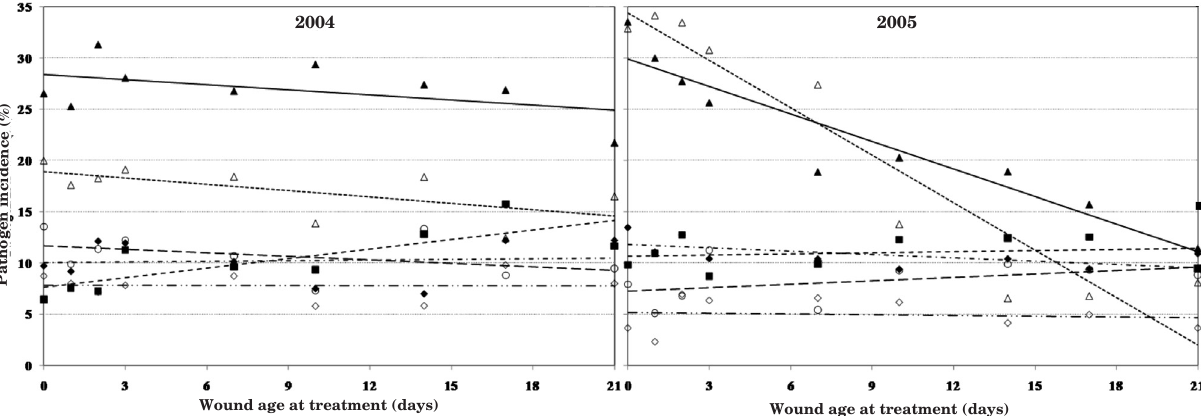
Figure 1. Linear regression lines (August inoculated [ — ]; July inoculated [ - - - ]; August painted [ — — ]; July painted [ — - ]; August water [ – - – ]; July water [ – - - ]) fitted to the mean pathogen incidence (August inoculated [ ▲ ]; July inoculated [ ▲ ]; August painted [ n ]; July painted [ ¡ ]; August water [ t ]; July water [ ¯ ]) over wound age at treatment for the significant season × pruning time × wound age at treatment × treatment interaction observed in the 2004 and 2005 pruning Table 1. Coefficients of equations ( y = a + b x ) following linear regression analysis of mean pathogen incidence in prun- ing wounds, which were made during July and August 2004 and 2005 and either painted, water treated or inoculated with Eutypa lata , Phaeomoniella chlamydospora , Neofusicoccum australe and Phomopsis viticola directly after prun- ing, 1, 2, 3, 7, 10, 14, 17 and 21 days after pruning, over wound age at treatment for the significant year × pruning time × wound age at treatment × treatment interaction.